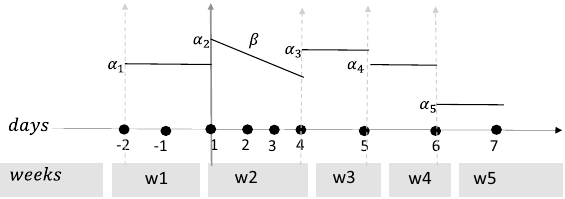
Figure 3. Illustration of Model 2. “Week” is a factor and varies from w1 to w5, “days” is a numerical variable associated with the days of sampling. As seen in the graph, α j determines the intercept associated with each week and β is the slope of daily variation of the synthetic variable during the first week after the diet change. Slope β is applied only during week 2 because of the use of the indicator